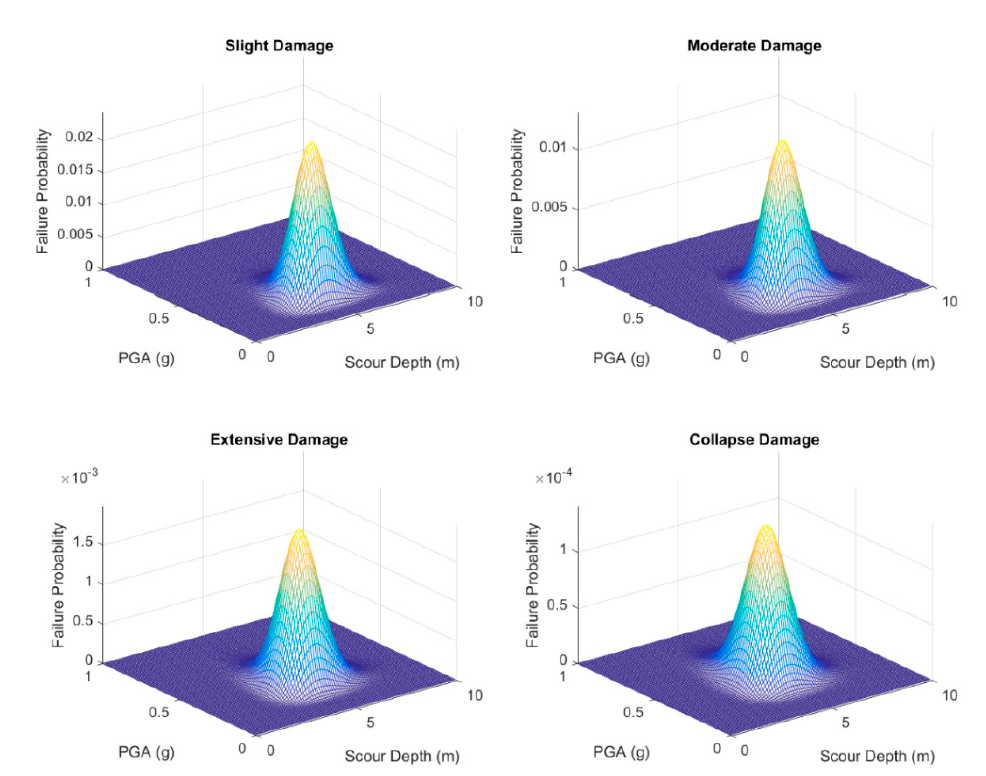
Figure 21. Joint failure probability under 4 m immersion depth against floods with a 100 year return period.